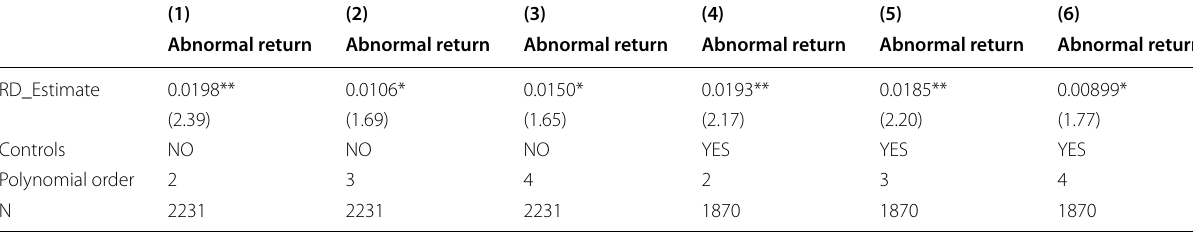
Table 7 Abnormal Returns RDD Results (The nonparametric approach)